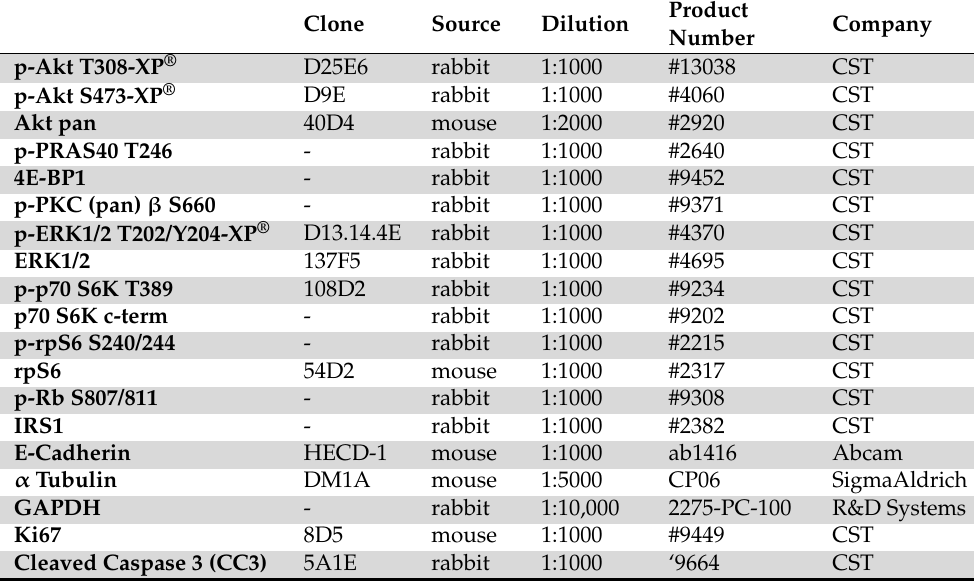
Table 3. Primary antibodies used in Western blot and immunofluorescence analysis. A list of primary antibodies used in this study depicting the name of the antibody, source, dilution ratio, product number and source. Cell signaling technology (CST; Danvers, MA, USA); Abcam (Cambridge, UK); SigmaAldrich (St. Louis, MO, USA); R&D Systems (Minneapolis, MN,